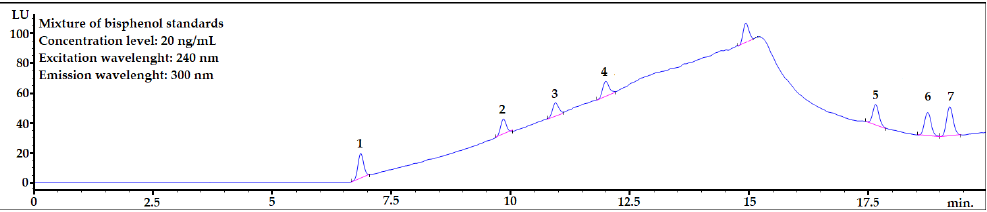
Figure 1. The mixture of bisphenol standards dissolved in ACN:H 2 O 1:1 ( v / v ). 1—BADGE · 2H 2 O, 2—BPF, 3—BPE, 4—BPA, 5—BADGE · 2HCl, 6—BADGE, 7—BPP.